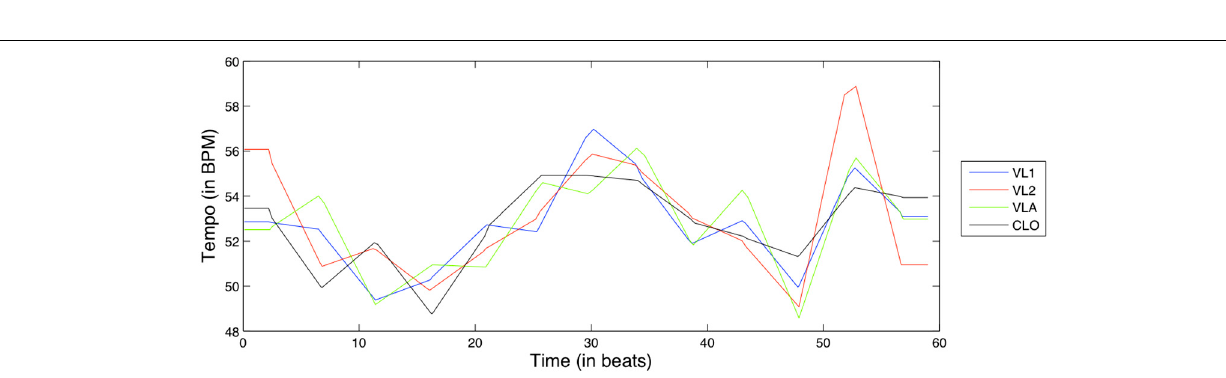
FIGURE 5 | Excerpt from the spectral crest feature from exercise D1, for all instruments.